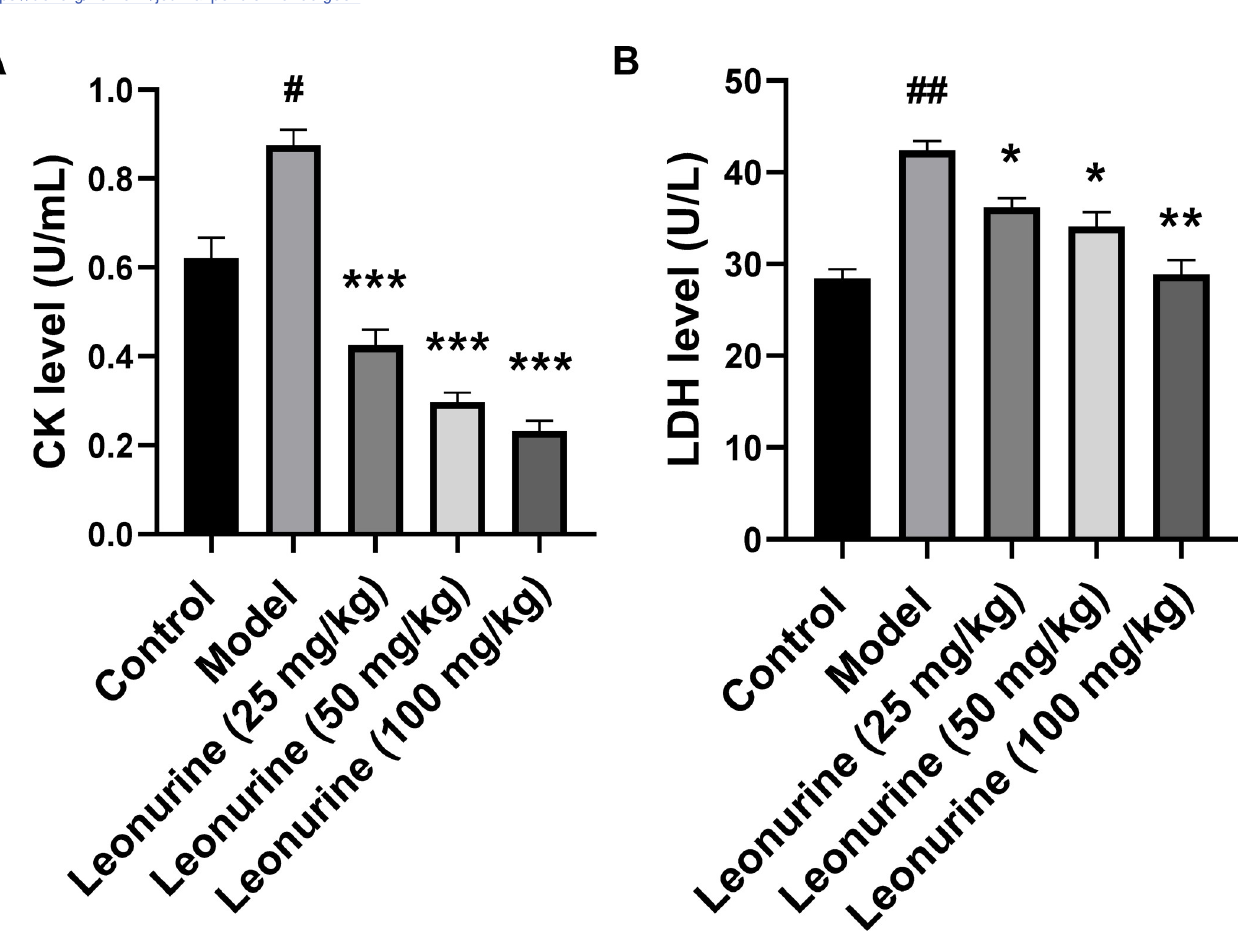
Fig 2. Leonurine reduced myocardial injury in rats with ISO-induced heart failure. Myocardial injury is responsive to LDH and CK. Leonurine decreased levels of (A) CK and (B) LDH in plasma in heart failure rats induced by ISO. #P < 0.05, ##P < 0.01, model group vs. control group; � P < 0.05, �� P < 0.01, ��� P < 0.001, leonurine groups vs. model group. CK, creatine kinase; LDH, lactic dehydrogenase.